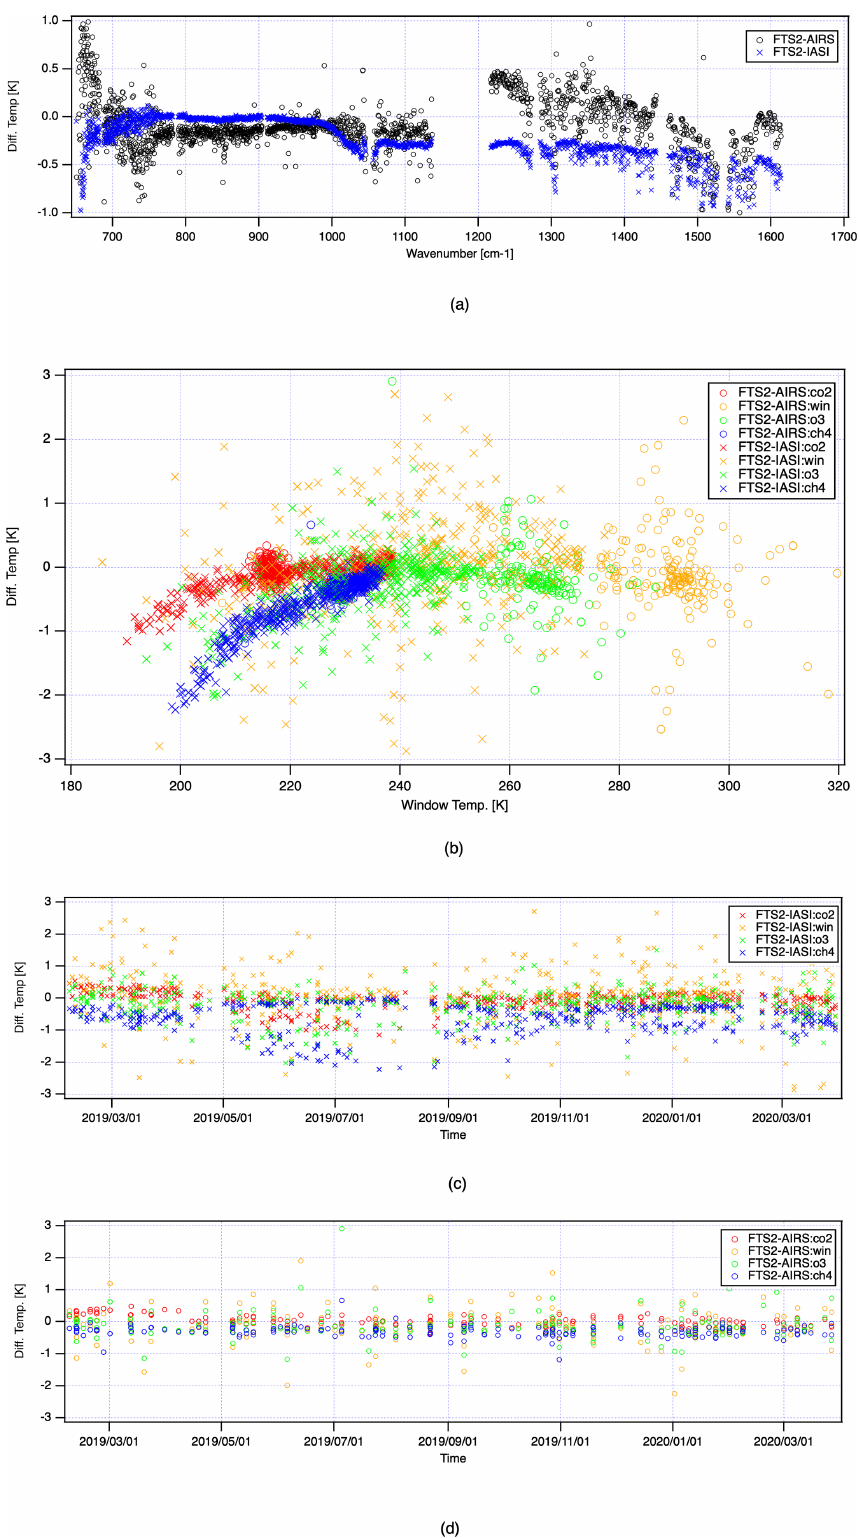
Figure 15. Inter-comparison between TANSO-FTS-2, IASI, and AIRS. (a) Entire averaged difference brightness temperature between TANSO-FTS-2, AIRS, and IASI in the entire spectral range. (b) Channel-dependent difference against window temperature. (c) Time series of averaged difference brightness temperature between TANSO-FTS-2 and IASI within spectral regions of CO 2 , window, O 3 , and CH 4 channels. (d) The same as (c) except for TANSO-FTS-2 and